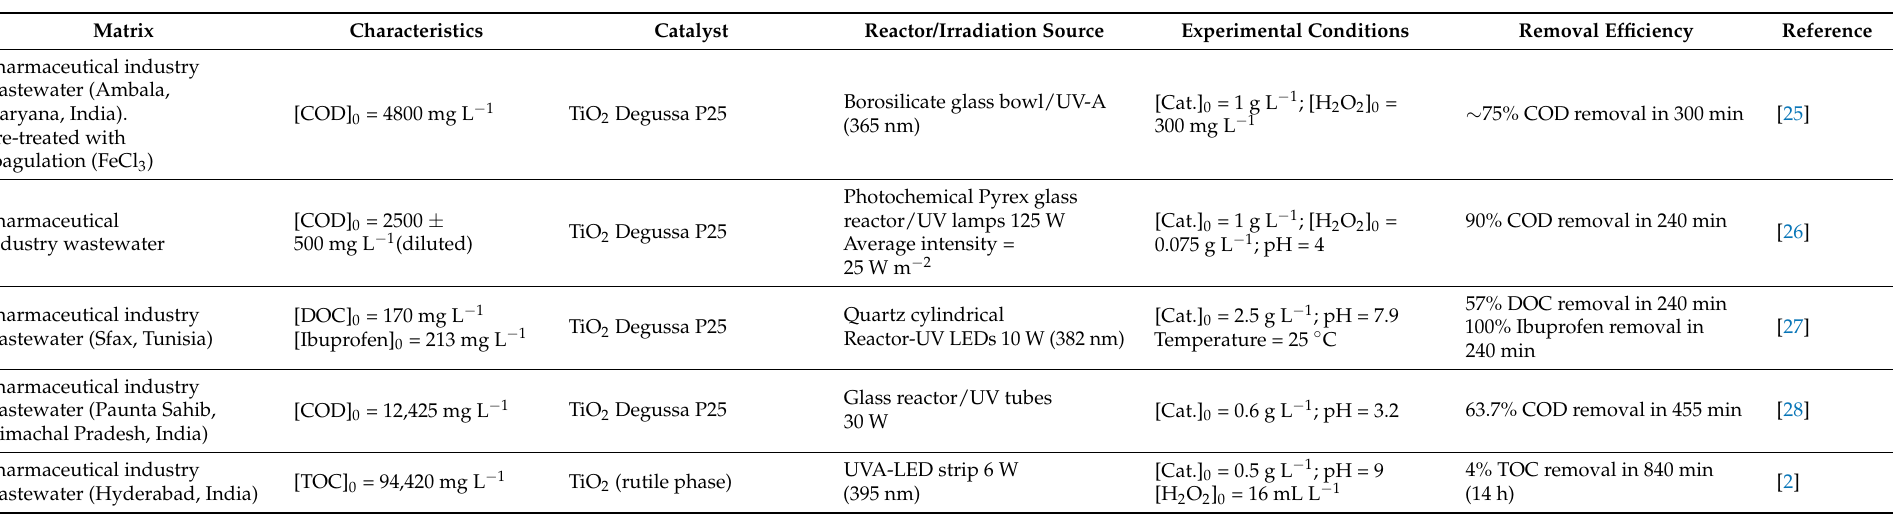
Table 4. Heterogeneous photocatalysis for the treatment of pharmaceutical industry